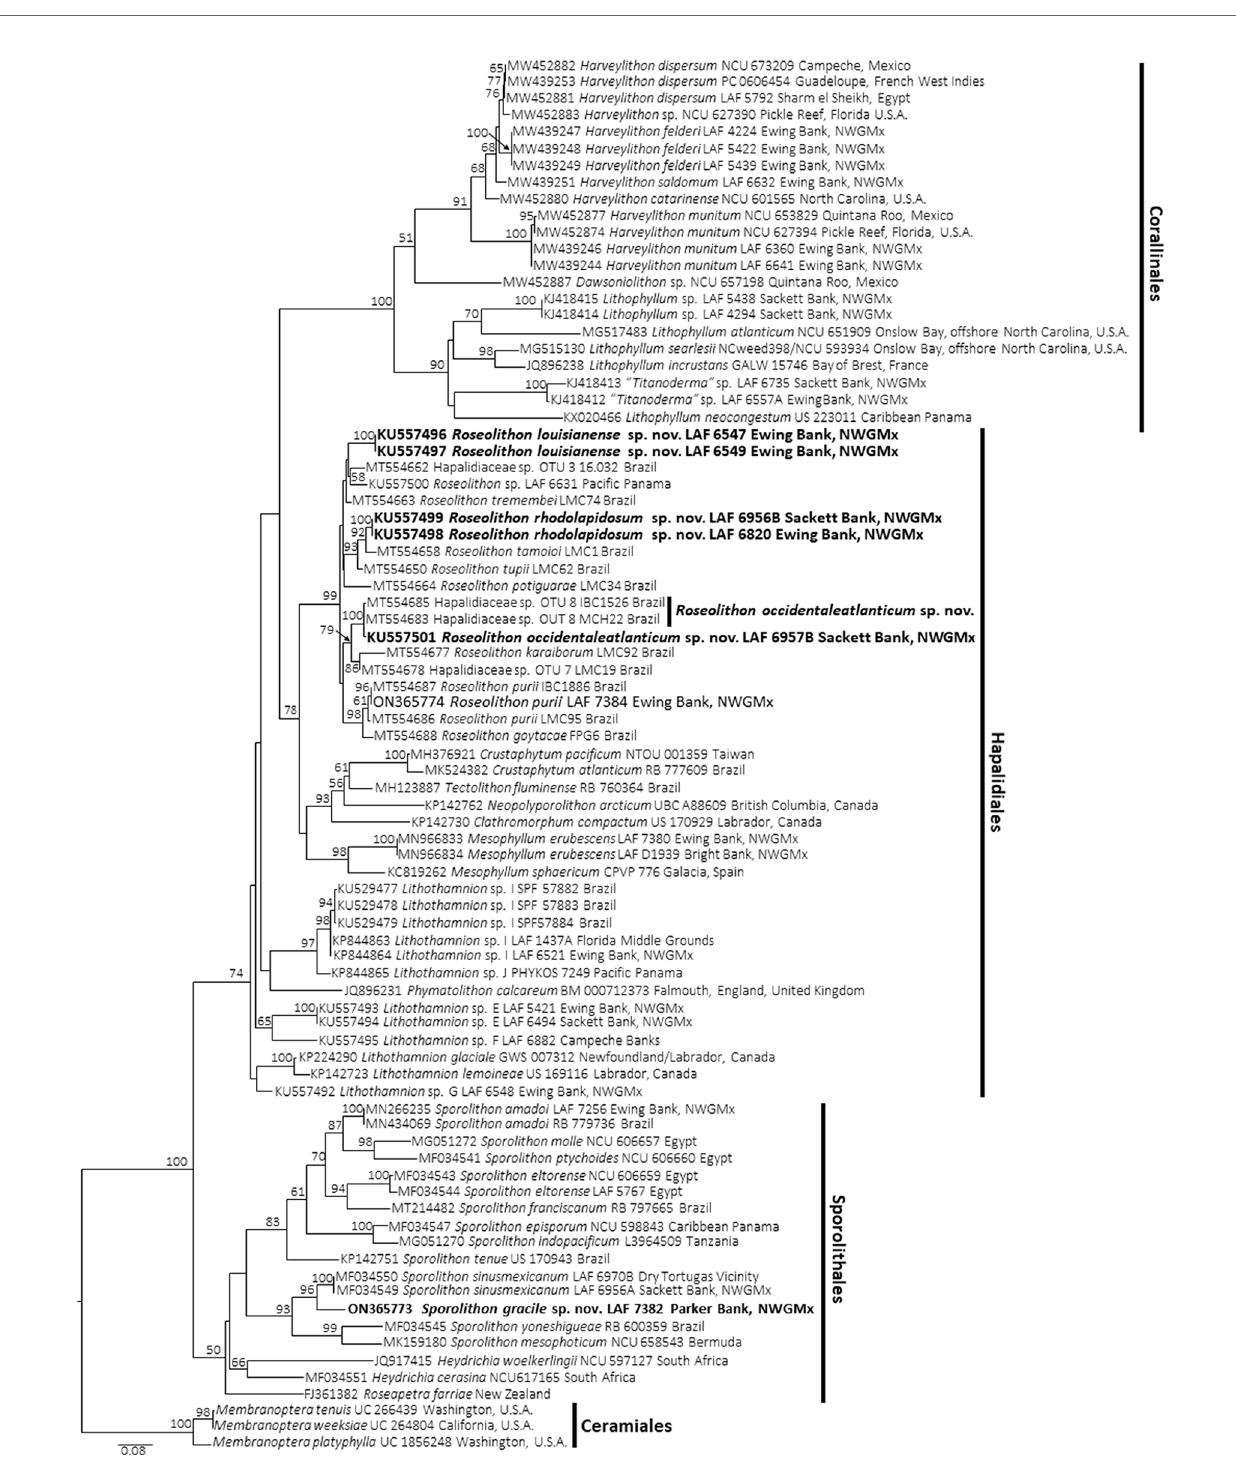
FIGURE 1 | Maximum Likelihood analyses of psb A. Node values represent bootstrap values out of 1,000 replicates. Newly described species shown in bold. NWGMx, northwestern Gulf of Mexico.